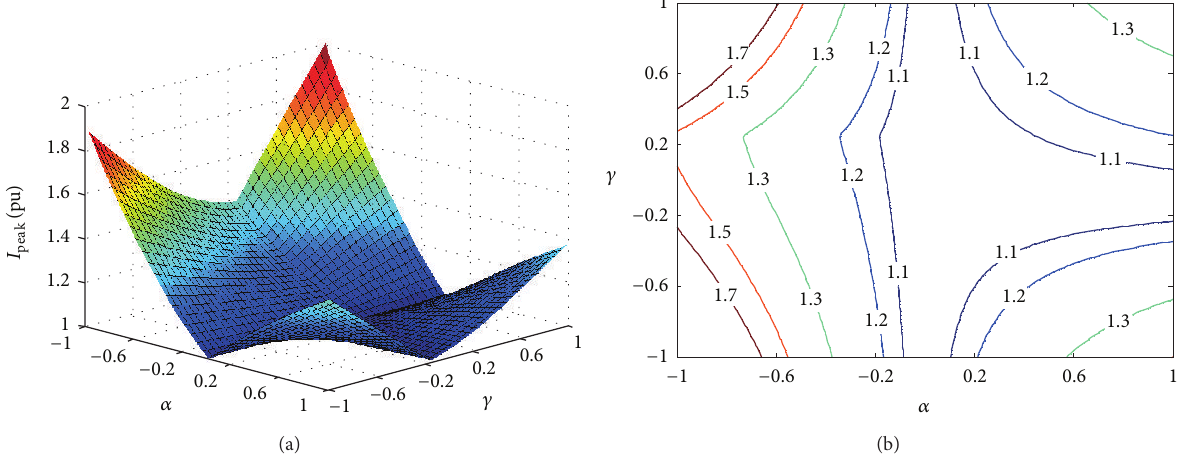
Figure 3: Three-dimensional mesh and contour lines of peak current. (a) Three-dimensional mesh. (b) Contour lines.